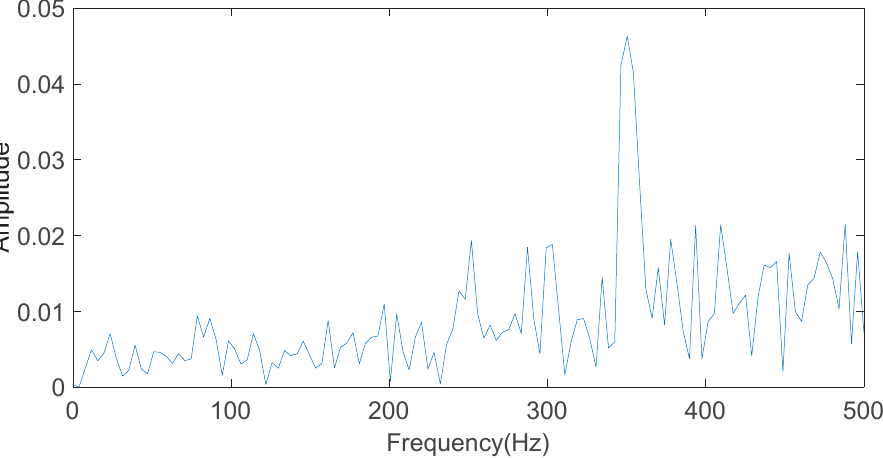
Figure 7. The frequency of the IMF1 component obtained by Fast Fourier Transform (FFT).